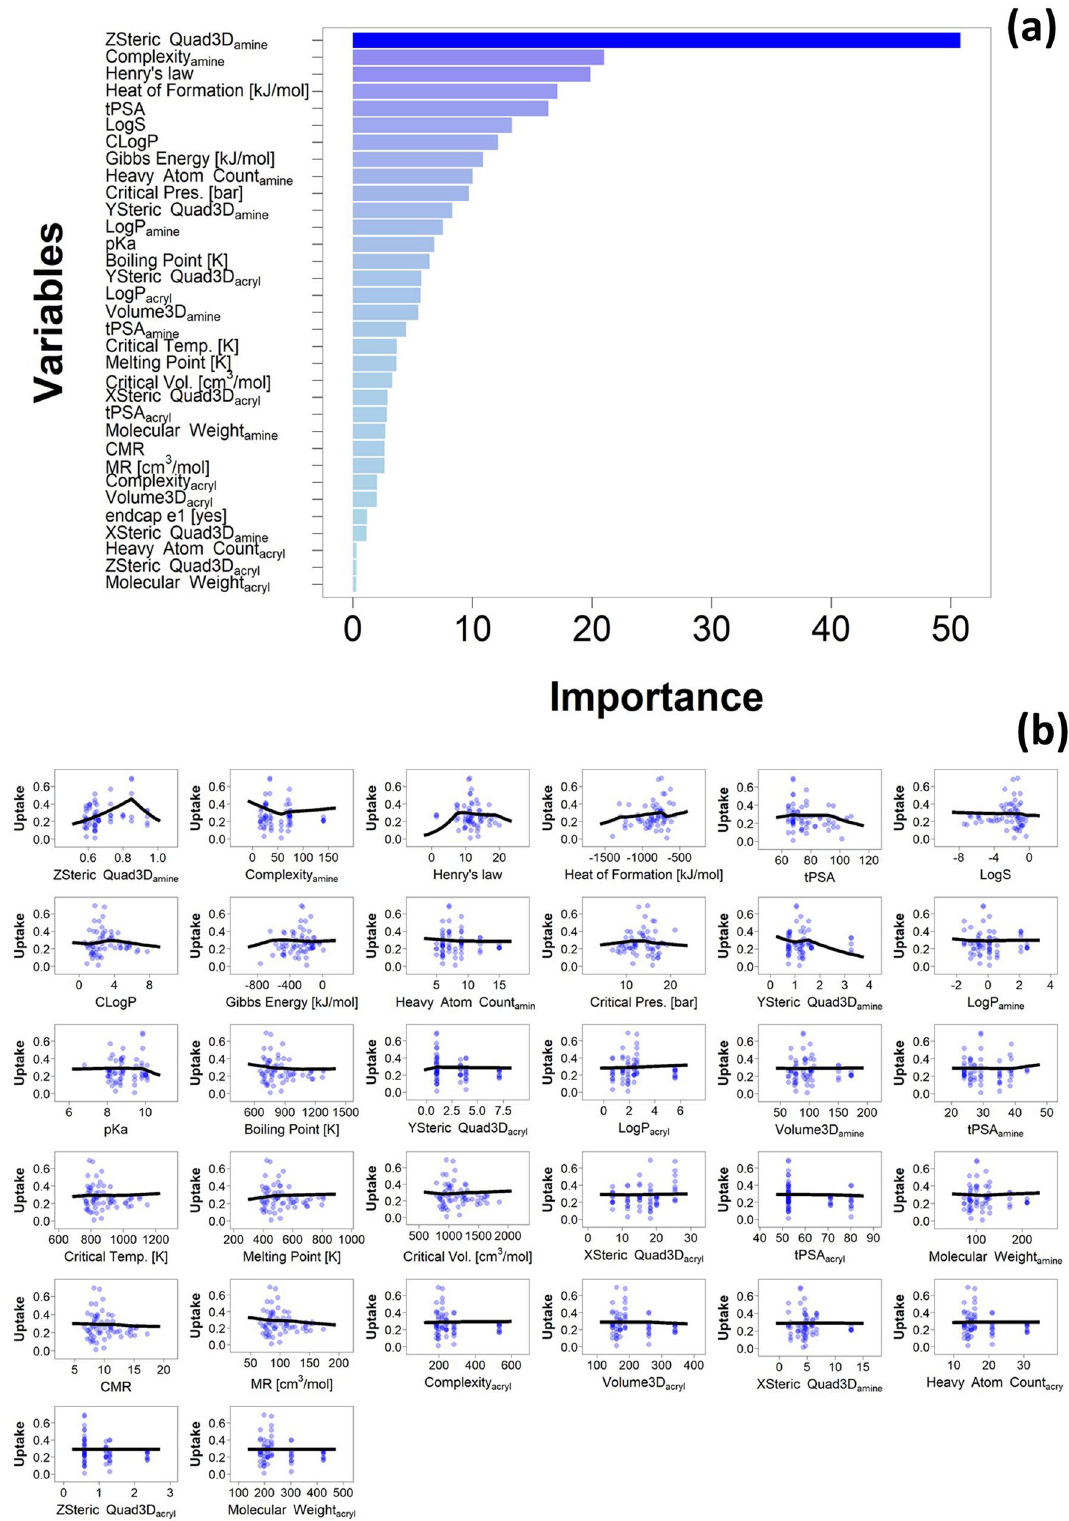
Figure 5. Variable importance in optimised bagged MARS model ( a ) and partial dependency plot of optimised bagged MARS model compared to experimentally obtained data for 10 min uptake of DEX into cartilage ( b